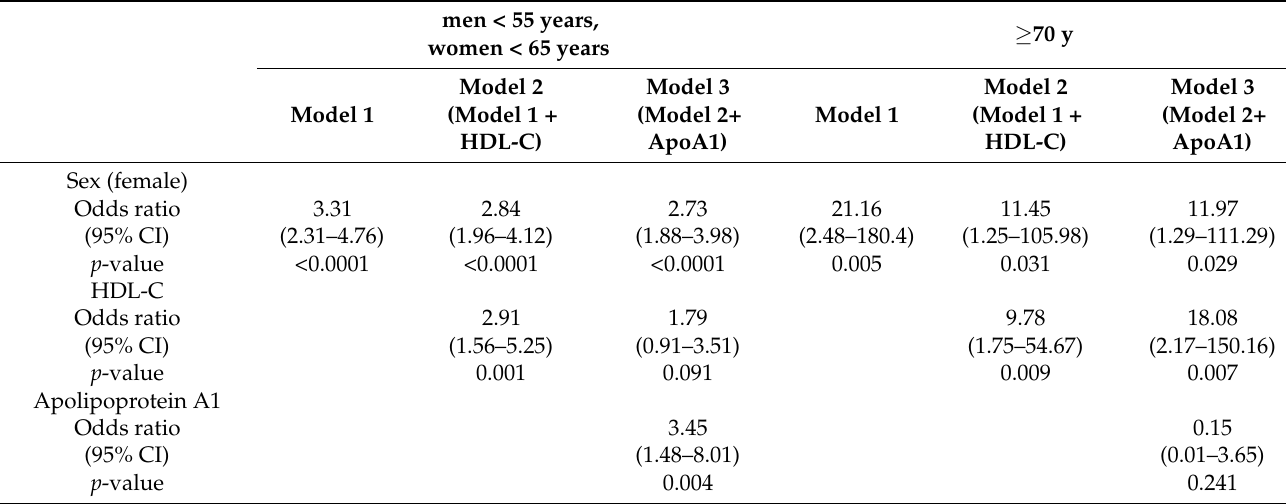
Table 2. Multivariate analysis of the contribution of biological variables to the relative odds of CVE-free survival in familial hypercholesterolemia (FH) patients.